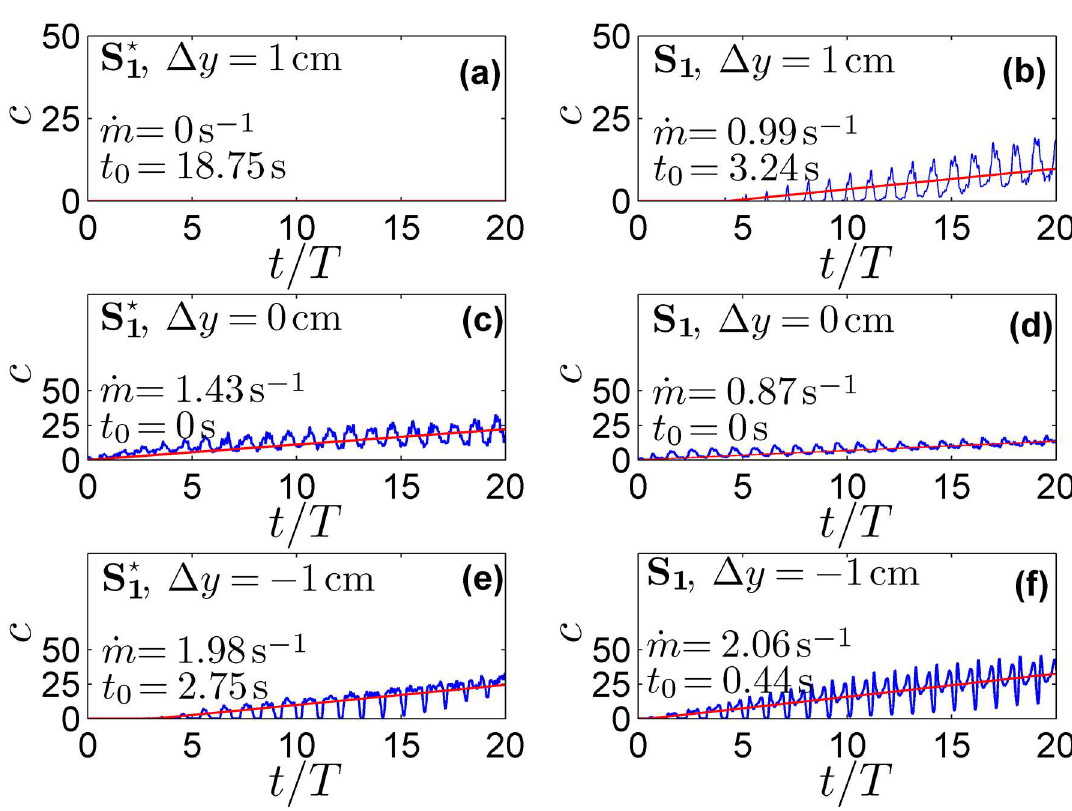
Fig 4. Time evolution of the normalized drug concentration and relative linear fitting. The blue lines represent the time evolutionof the normalized drug concentration at different cross sectionsfrom the injectionpoint for (a) S ? line indicatesthe relativelinear fitting ( (cid:22) c ).